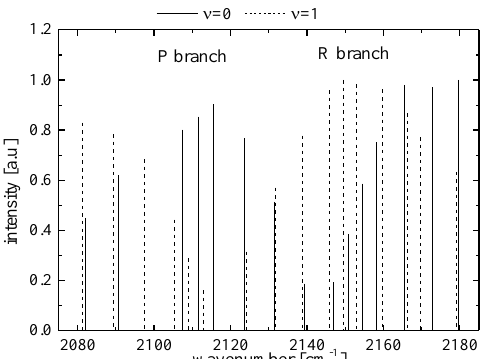
Figure 34. CO band stick spectrum containing 31 ground and hot band lines measured with an EC-QCL spectrometer. The intensities of the lines are normalized. In general, the intensities of the hot band lines are about 20 times smaller than the ground state lines, p = 0.35 mbar, P = 3 kW [66], © IOP Publishing. Reproduced with permission. All rights reserved.